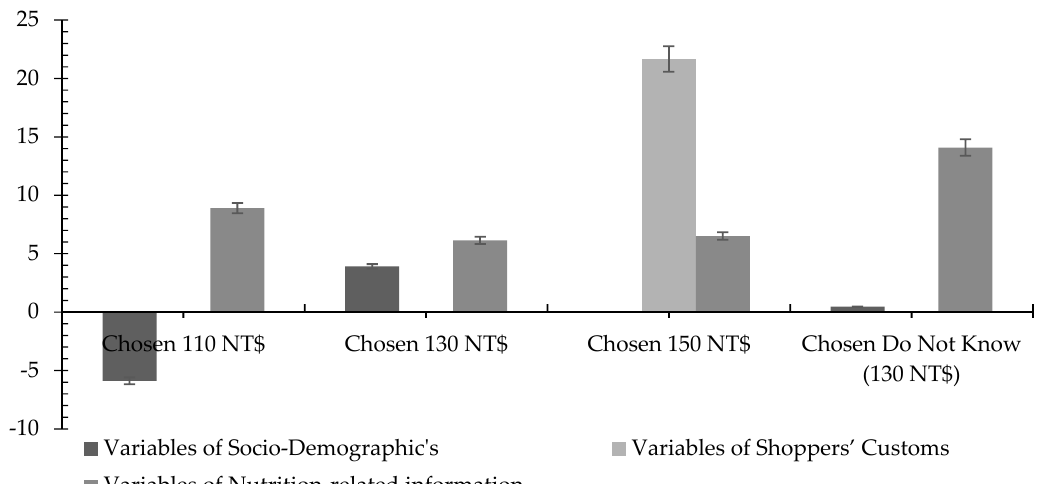
Figure 1. The estimation of WTP for nutrition information. Note: The error bars denote statistical significance at 5% significance. Source: Illustrated by this research.